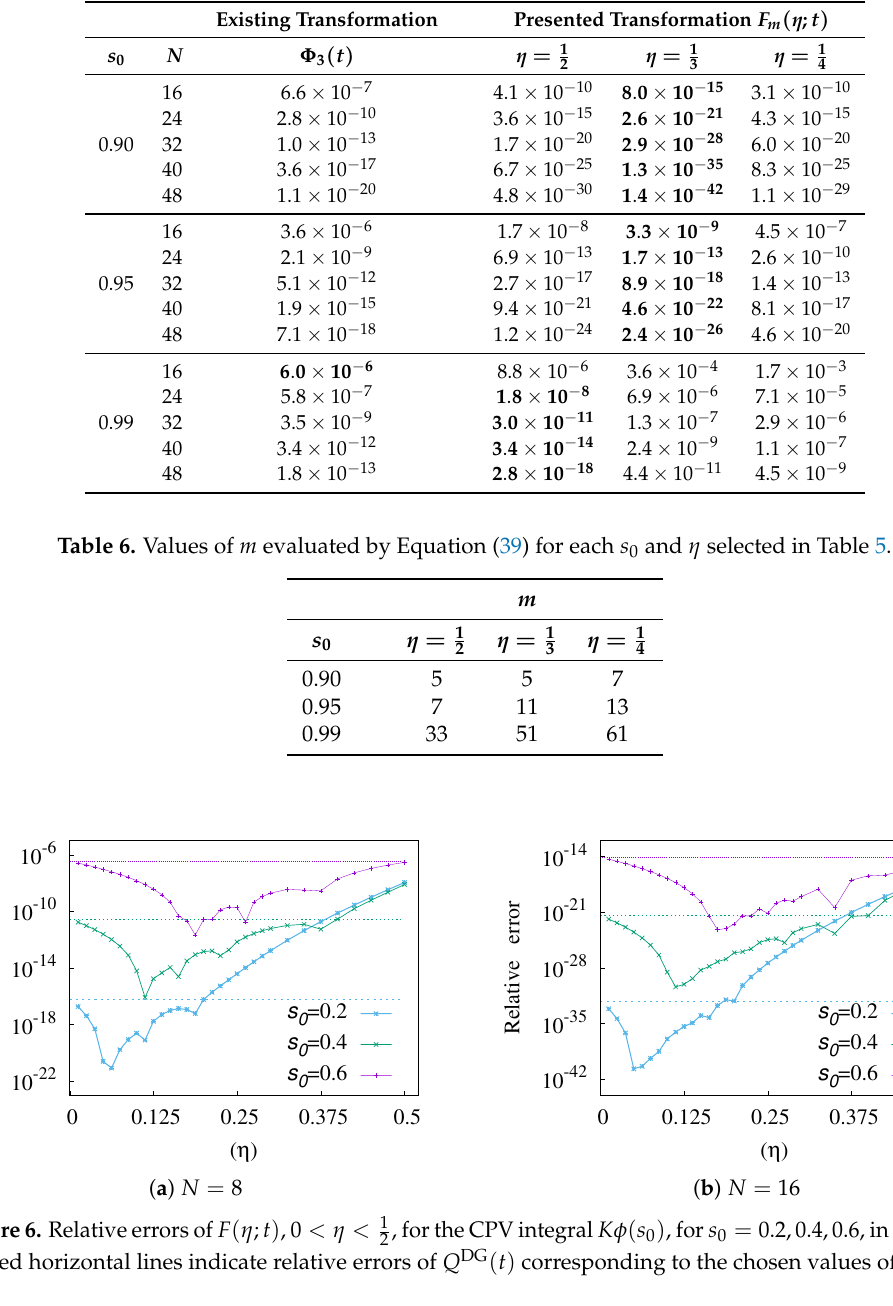
Table 5. Relative errors of the N -point Gauss-Legendre quadrature rule corresponding to the composite transformation Φ 3 ( t ) and the presented transformation F m ( η ; t ) for the CPV integral K φ ( s 0 ) , with s 0 ’s near the end-point, in Example 3.